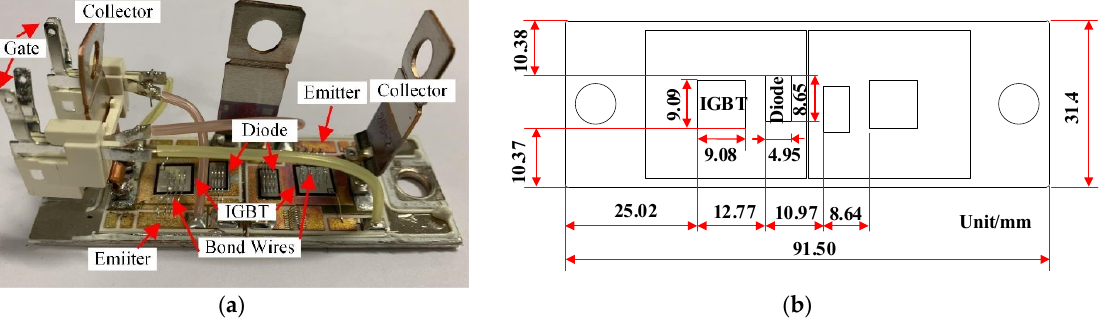
Figure 6. ( a ) IGBT module GD50HFL120C1. ( b ) Dimensions of GD50HFL120C1. The bond wires of diode and gate have been removed in the FEM model. The struc ‐ ture and boundaries of the FEM model are shown in Figure 7a. The boundary conditions are set as follows. The ambient temperature is set at 20 °C. All of the boundaries’ condi ‐ tions are set as electric insulation in the physical field of electric currents, except a DC source with a high potential on the collector side and ground potential on the emitter side. A convection coefficient of 3000 W/m 2 ∙ K is defined on the bottom surface of the baseplate to simulate a wind ‐ cooling heatsink; the rest of the surfaces are set as 12.5 W/m 2 ∙ K for free convection air in the physical field of heat transfer in solids. The physical fields of heat transfer in solids and electric currents are defined as the source and destination in the multi ‐ physics field of temperature coupling, respectively. All domains are used in electromagnetic heat source and boundary electromagnetic heat source, where the electric currents are set as the electromagnetic source and heat transfer in solids is set as the heat transfer source.